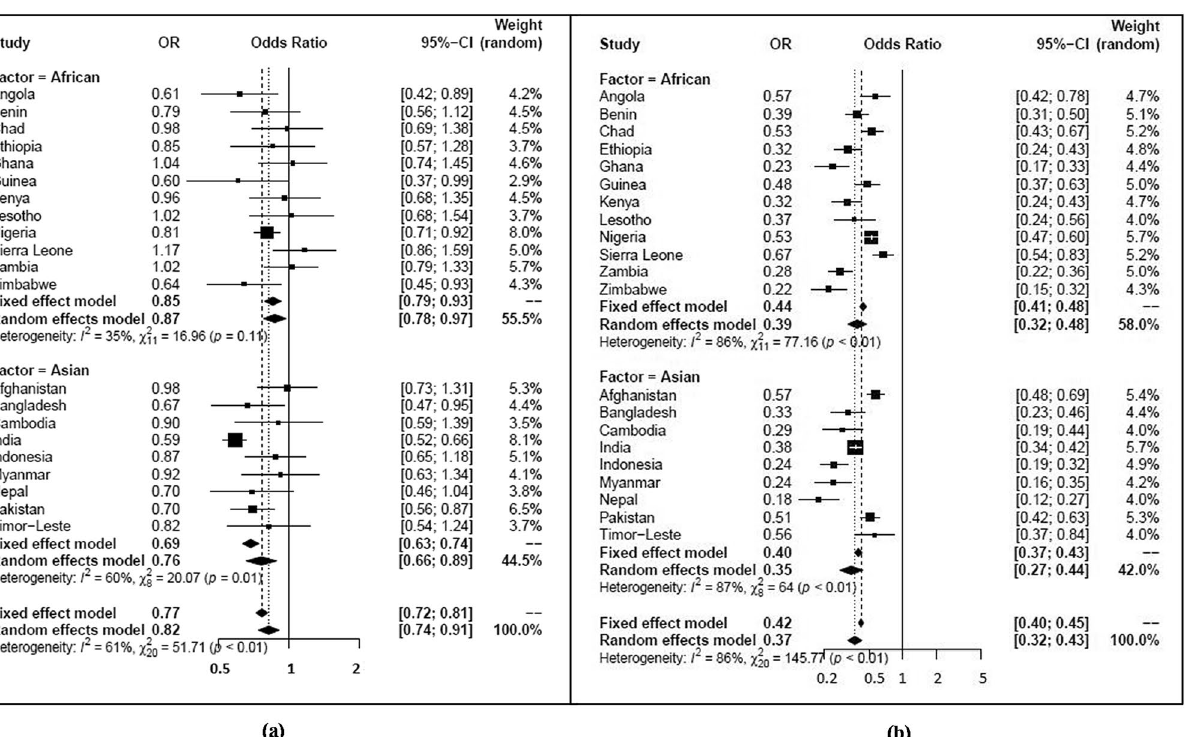
CI confidence interval, I 2 between study variation, OR odds ratio,